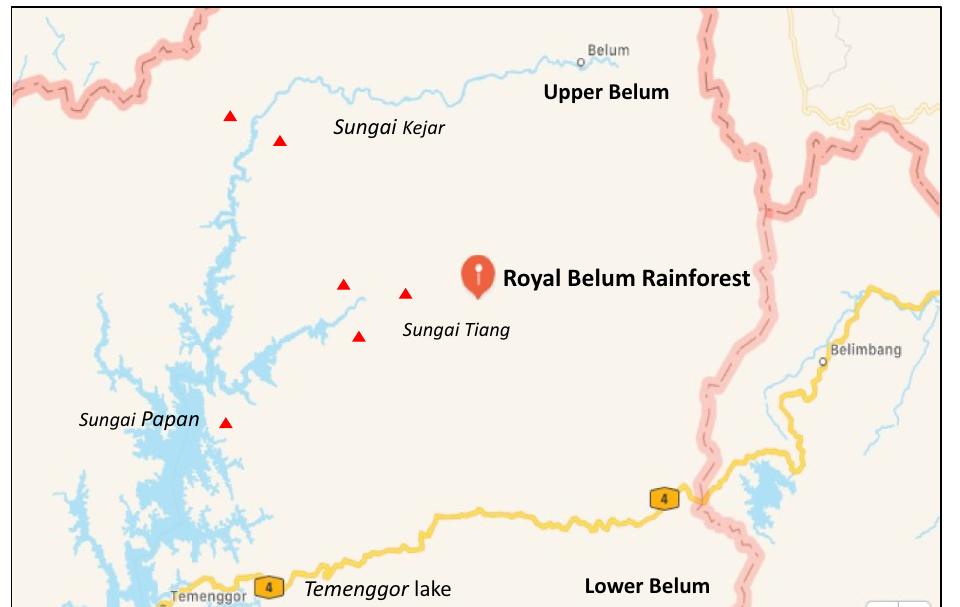
Figure 3. The distribution of salt licks at the Royal Belum Rainforest. Map details: Royal Belum Rainforest: Generated from GPS Coordinate (https:// www. gps- coord inates. net/); Latitude: 5°42 ′ 37 ″ N; Longitude: 101°31 ′ 56 ″